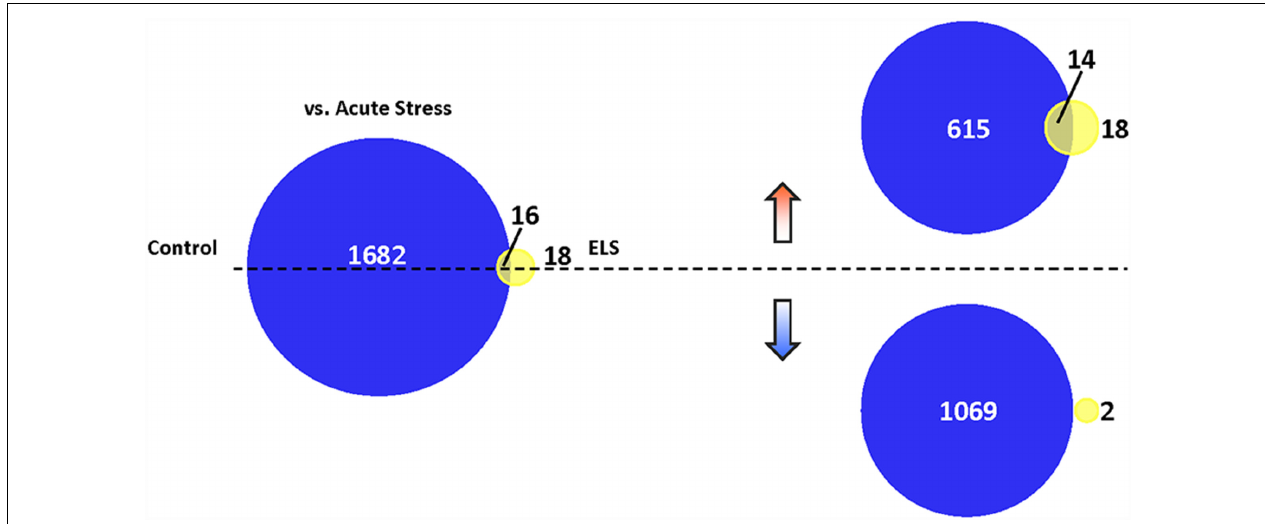
FIGURE 5 | Translational repression in ELS mice following AS. Venn diagram depicting the number of genes altered in stressed control mice vs. unstressed control mice (dark blue), stressed ELS mice vs. unstressed ELS mice (yellow), and in both comparisons (yellow-blue overlap; p < 0.05). AS induces a markedly limited gene expression change in ELS mice relative to control mice. We found that AS induces 1,698 genes in control mice and 34 genes in ELS mice, with 16 genes common to both comparisons. Separating these AS-regulated genes based on the direction of their fold change revealed that AS upregulates 629 genes in control mice and 32 genes in ELS mice, with 14 genes commonly upregulated in both comparisons. In addition, 1,069 genes are downregulated in control mice and two genes downregulated in ELS mice by AS, with no genes common to both comparisons. ELS, early life stress; AS, acute stress.